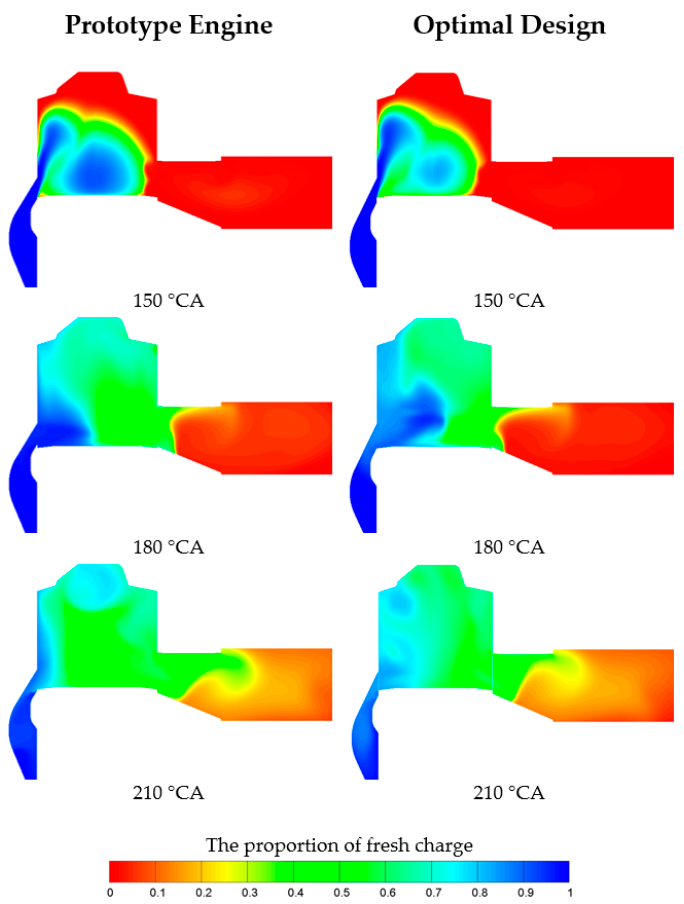
Figure 19. X cross-sectional views of the prototype engine simulation case and optimal design simulation case under the partial load operating condition.